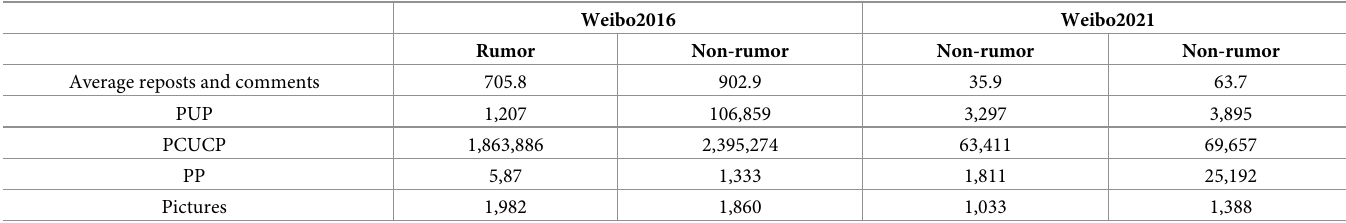
Table 2. Statistics of the Rumors and Non-rumors in Weibo2016 and Weibo2021